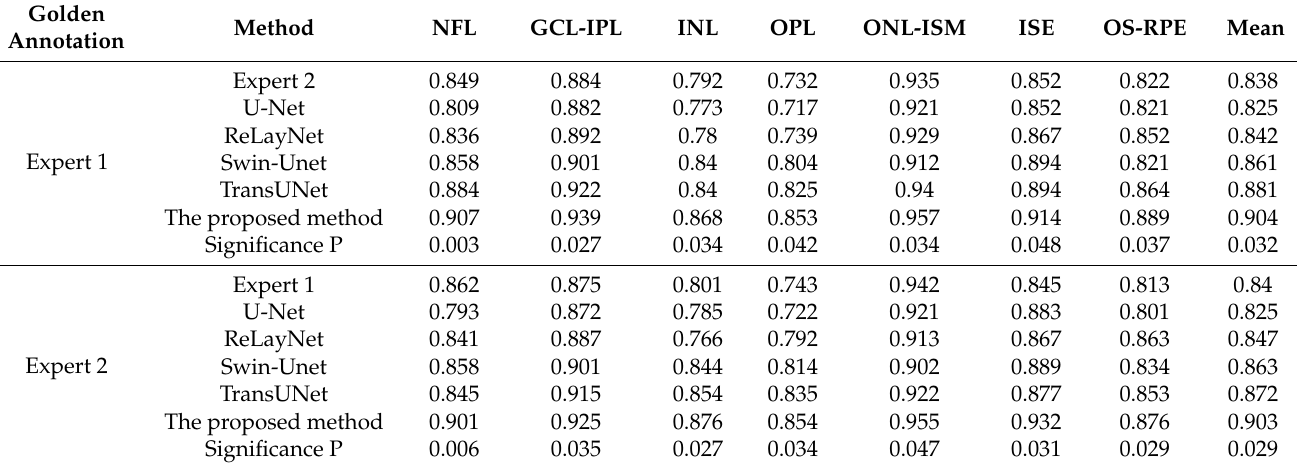
Table 1. Quantitative comparison of Dice coefficient and consistency index of segmentation results of each method layer on the Duke